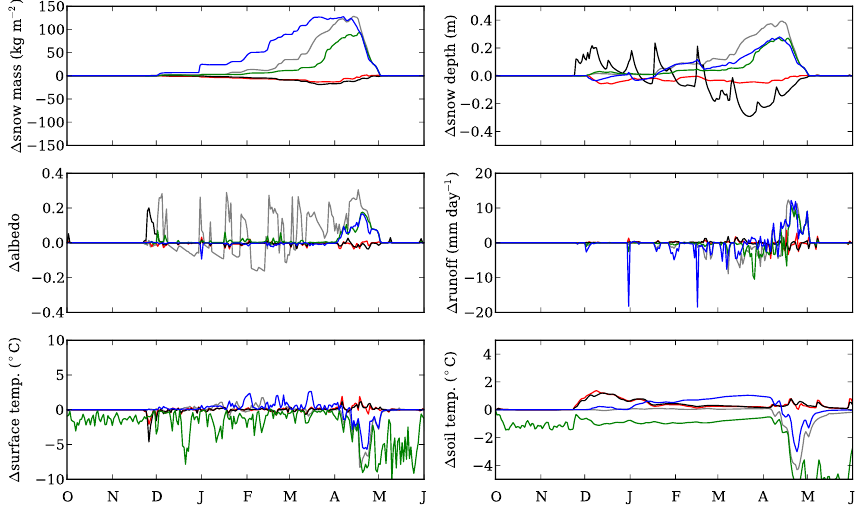
Figure 5. Differences between averages of simulations with prognostic snow albedo (grey lines), thermal conductivity (red), prognostic snow density (black), atmospheric stability (green) and prognostic liquid water (blue) parametrizations switched on or